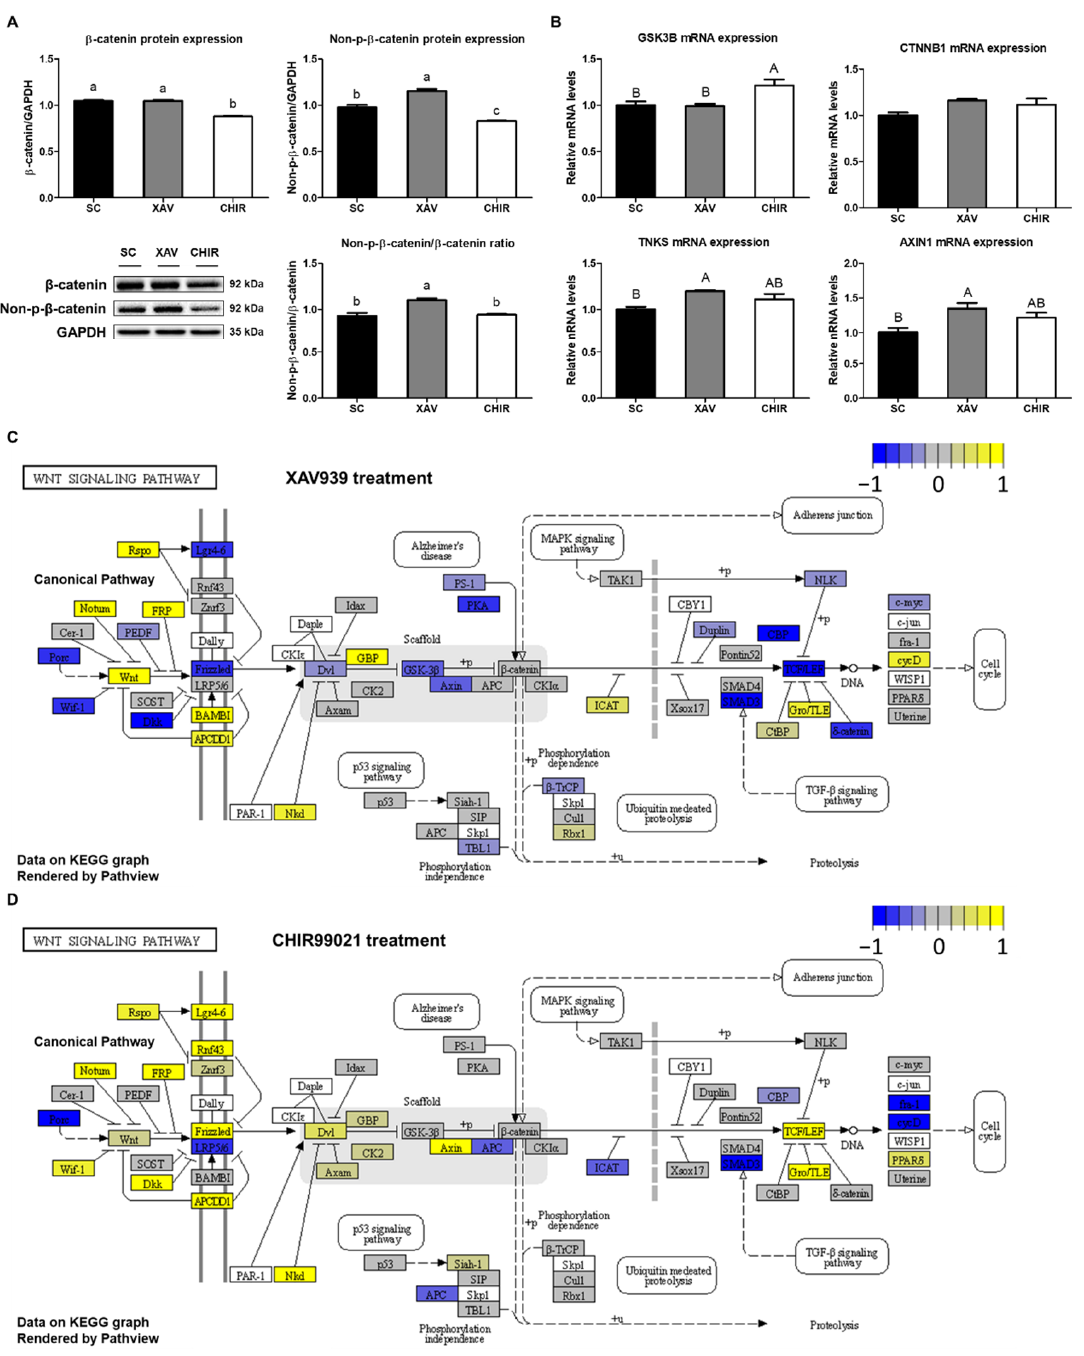
Figure 6. Changes in target factors in PMSCs by addition of Wnt signaling pathway regulators. ( A ) β -Catenin and non-phospho- β -Catenin (active β -Catenin) protein levels and non-phospho- β - Catenin/ β -Catenin ratio in PMSCs. ( B ) Quantitative gene expression levels of GSK3B , CTNNB1 , TNKS , and AXIN1 in PMSCs. ( C ) Changes in expression of Wnt signaling-related factors in XAV939 treated cells. ( D ) Changes in expression of Wnt signaling-related factors in CHIR99021 treated cells. Values are presented as mean ± SE. a–c Different letters represent statistically significant differences among treatment groups ( p < 0.01). A,B Different letters represent statistically significant differences among treatment groups ( p < 0.05). Full-length blots are presented in Supplementary Figure S6.